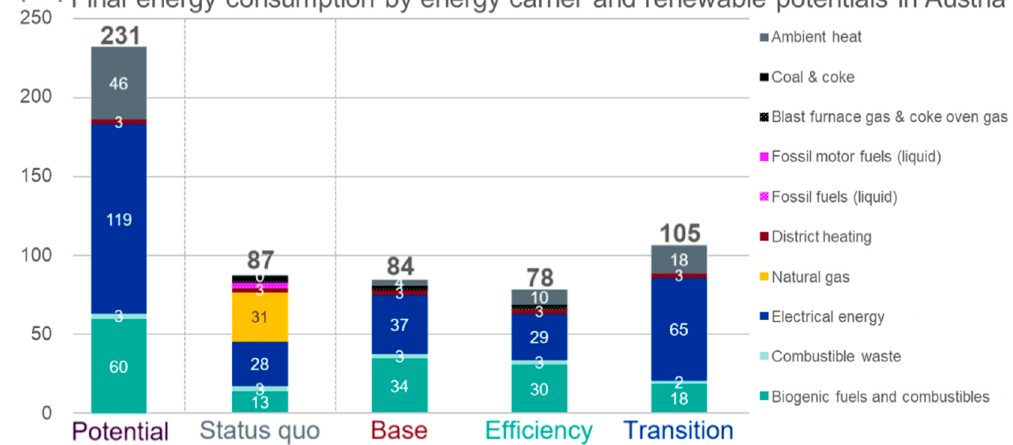
Figure 4. Final energy consumption of the Austrian Industry by energy carrier—comparison of the renewable potential with the status quo and the three scenarios with. On the left side the considered total renewable potential in Austria is shown (based on [7,16,17]). On the left side the status quo (2019) is listed [5] and in the middle the calculated FEC based on the defined scenarios.